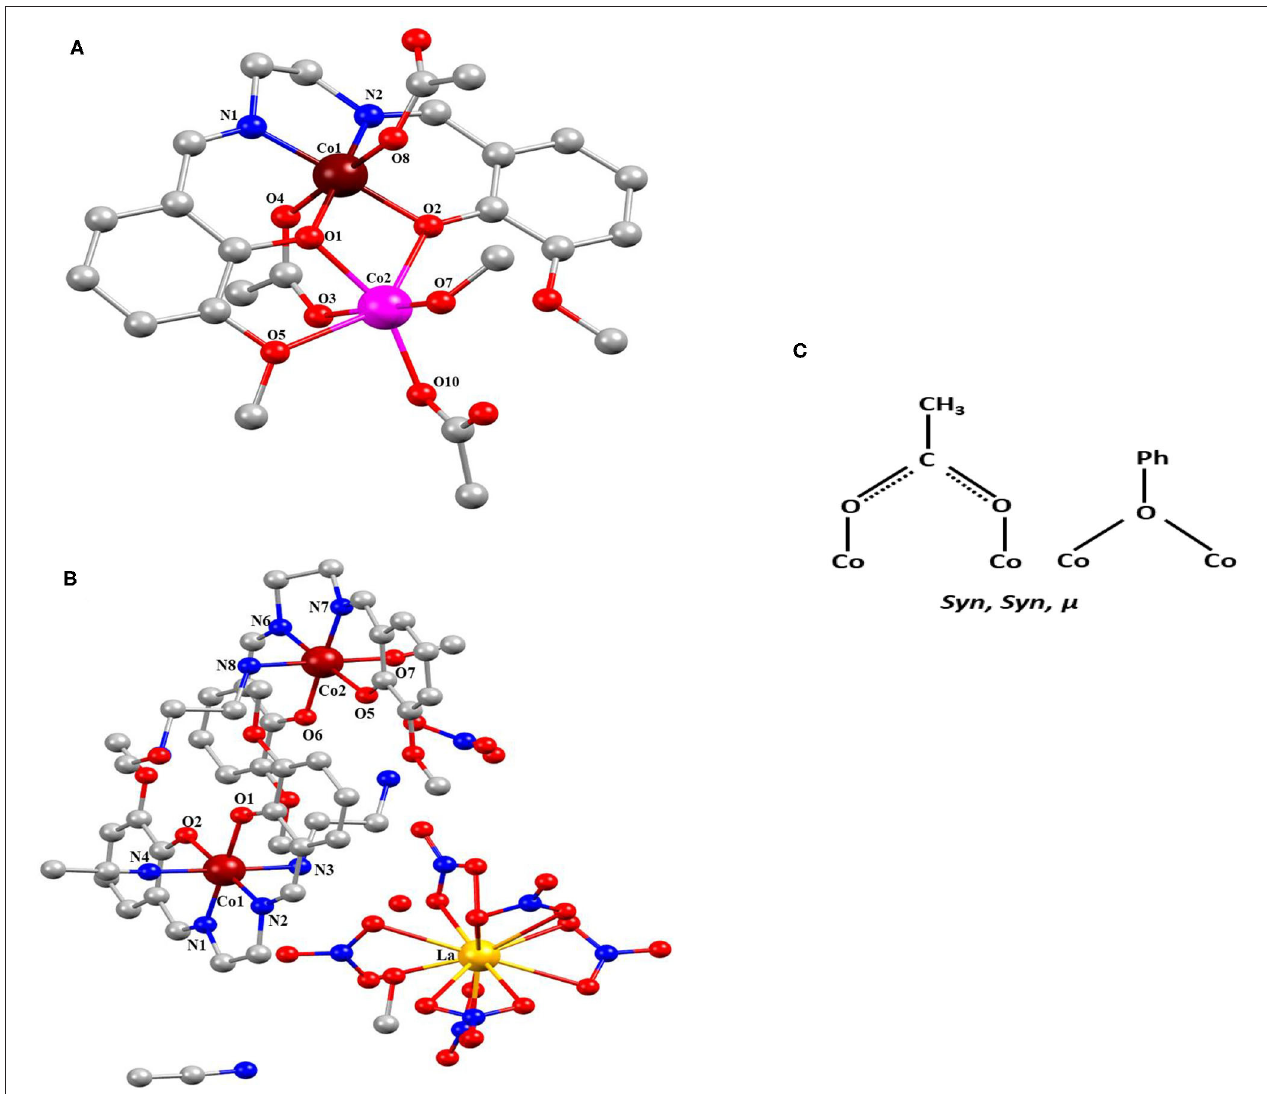
FIGURE 1 | (A) Complex 1 and (B) complex 2 [pink, Co(II); blackish brown, Co(IV); yellow, La; red, O; blue, N; gray, C and H removed for clear structure]. (C) Coordination modes of complexes 1 and 2.